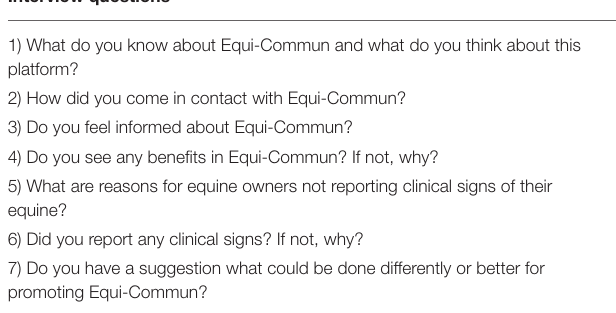
TABLE 2 | Interview questions asked to equine owners during semi-structured telephone interviews on their knowledge and attitude toward Equi-Commun and on reporting clinical signs of their